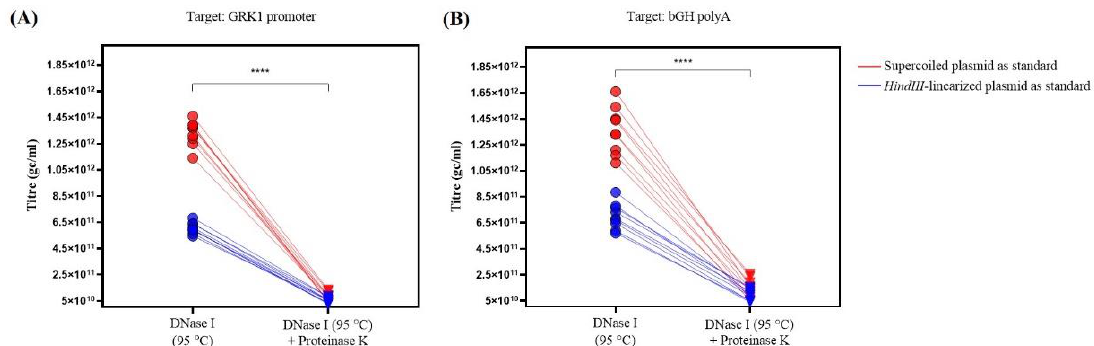
Figure 3. Graph representing the titer (gc/mL) calculated using the different DNA standards (supercoiled (red) vs. HindIII - linearized (blue)), on both qPCR assays (GRK1 promoter ( A ) and bGH polyA ( B )) for the AAV sample treated with DNase I versus same sample with the additional Proteinase K treatment. For all of the conditions tested, the titer was significantly lower in samples treated with both enzymes (**** p < 0.0001, Wilcoxon matched-pairs signed rank test; W = −171.0, n = 18 ( A , B )). Table 3. Genome copies per milliliter (gc/mL) calculated in average for each sample, from three independent experiments.